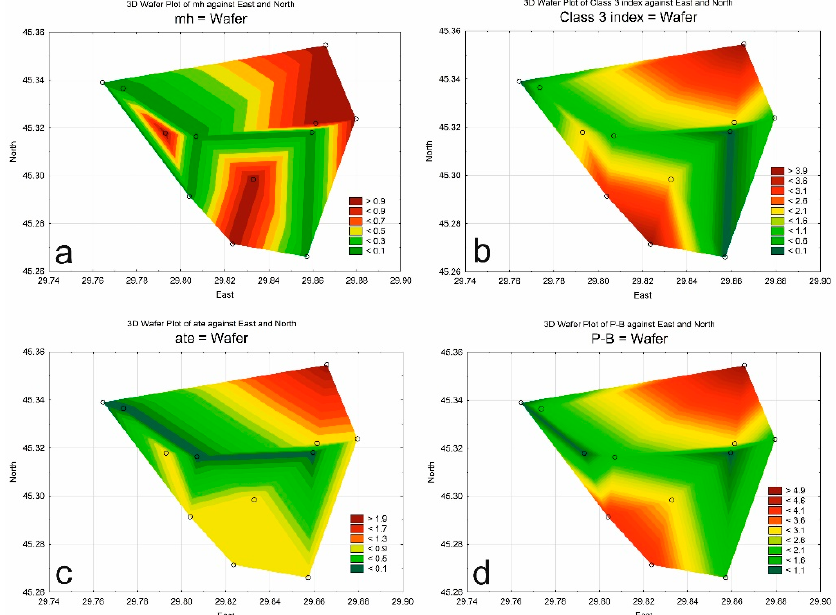
Figure 8. Statistically generated maps of mesohalobe species (mh) ( a ), species-indicators of class 3 of water quality defined by species-specific index SLA value ( b ), nitrogen-autotrophic taxa (ate), tolerating elevated concentrations of organically bound nitrogen ( c ), plankto–benthic species (P–B), ( d ) from the surface horizon in the Ukrainian part of Danube nearshore area in August 2018.